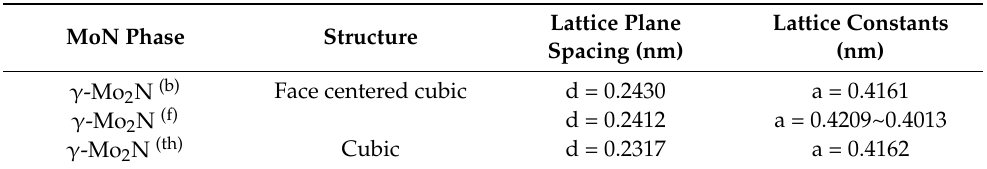
Table 2. Lattice plane spacing and lattice parameters of Mo 2 N films (f), compared with bulk (b), and theoretical values (th).